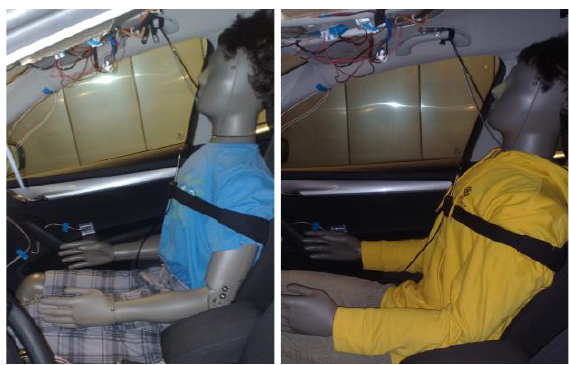
Fig. 1. Thermal manikin with summer and winter